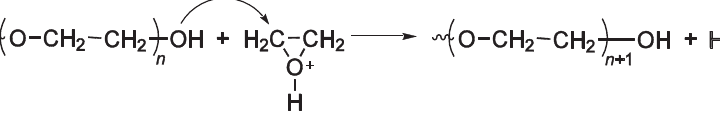
Figure 14. CROP via an activated monomer mechanism.